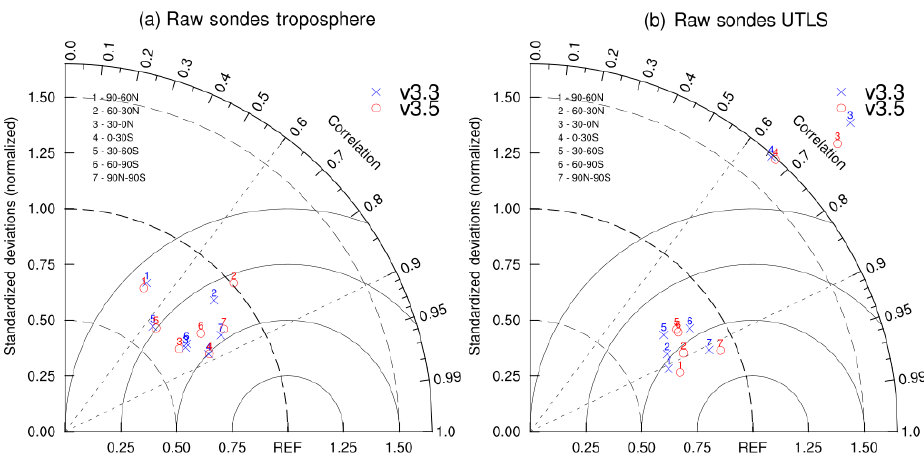
Figure 6. Taylor diagrams for (a) tropospheric columns and (b) UTLS columns for comparisons with raw sonde data. Red circles indicate v3.5; blue crosses indicate